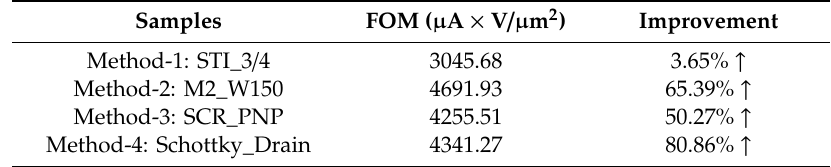
Figure 20. Secondary breakdown current distribution chart of HV nLDMOSs with embedded Schottky-diode modulation. Table 6. A comparison of FOM improvement percentages for four ESD strengthening